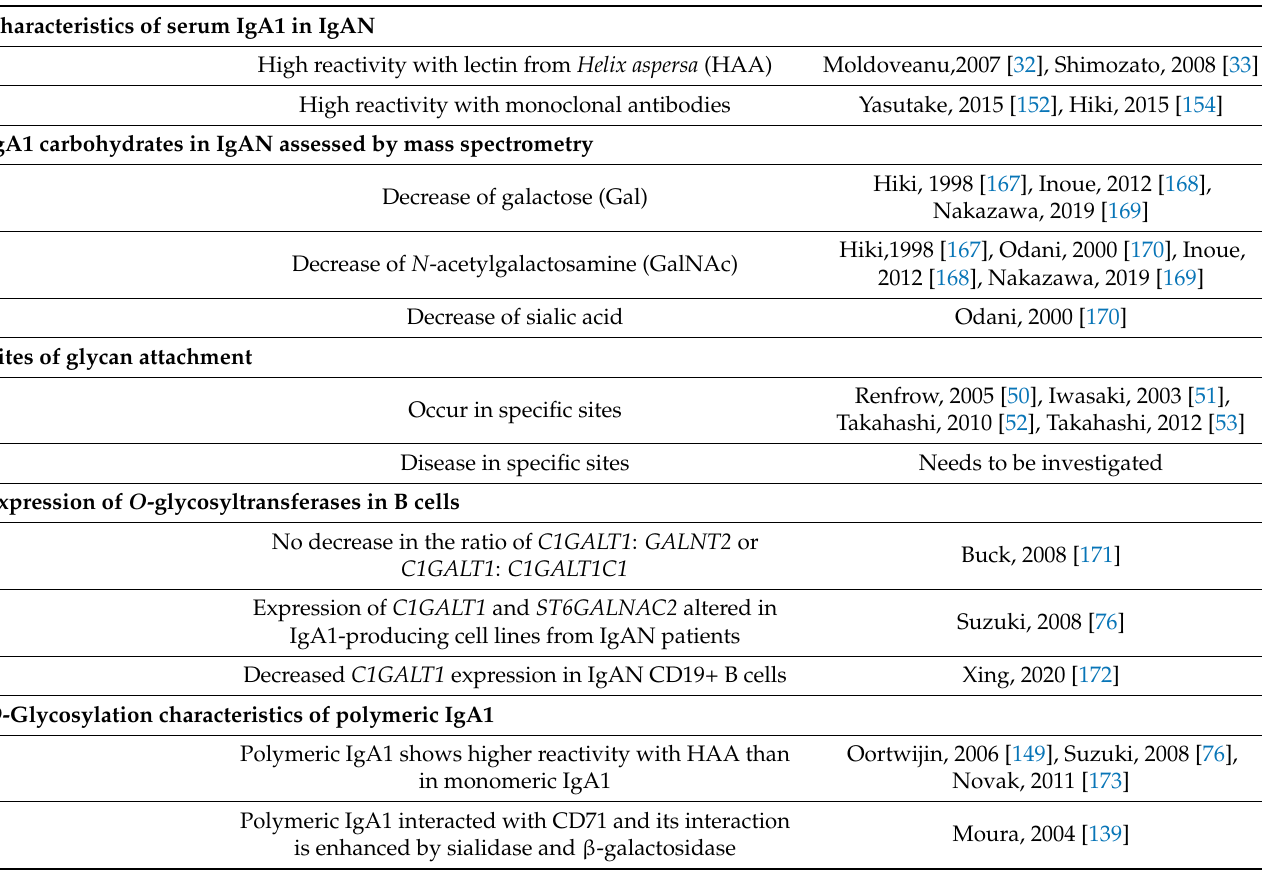
Table 1. What we know and what we do not know about O -glycosylation of IgA1 in IgAN. Characteristics of serum IgA1 in